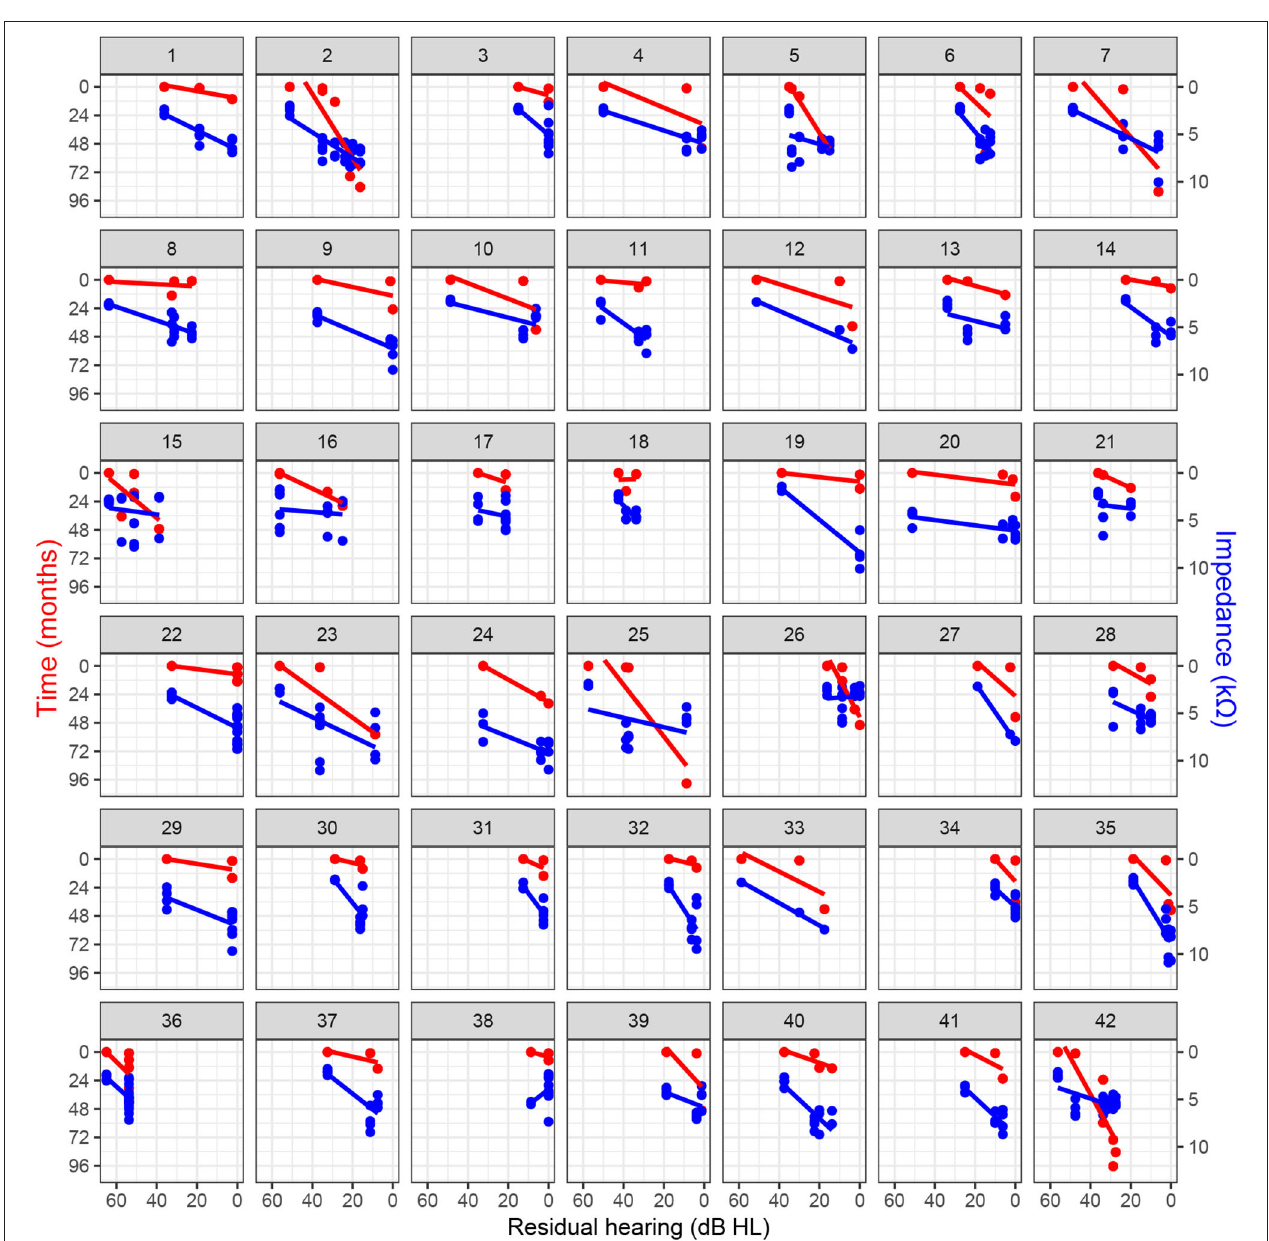
FIGURE 2 | Residual hearing progression over time and association with clinical electrode impedance for basal electrodes (i.e., contacts 9–12) with regression